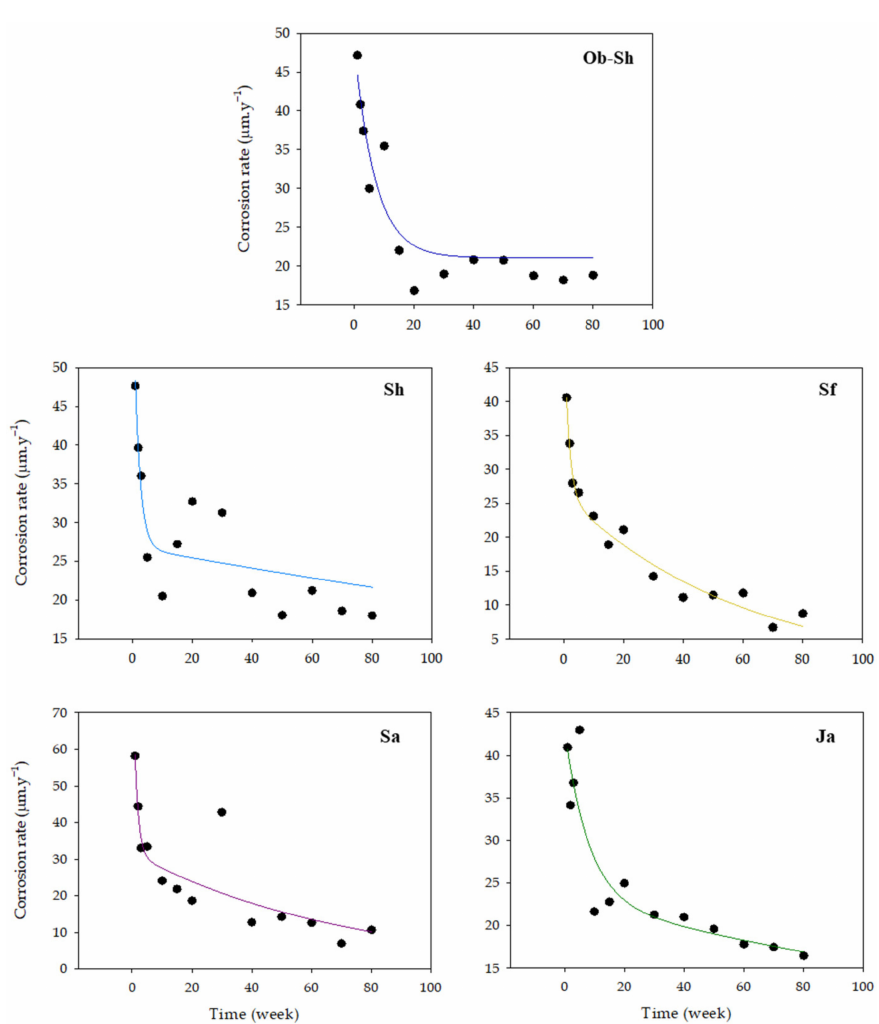
Figure 4. Variations in the CR of CSX36 specimens over 80 weeks of immersion in the studied Jeddah soil solutions at 23 ± 1 ◦